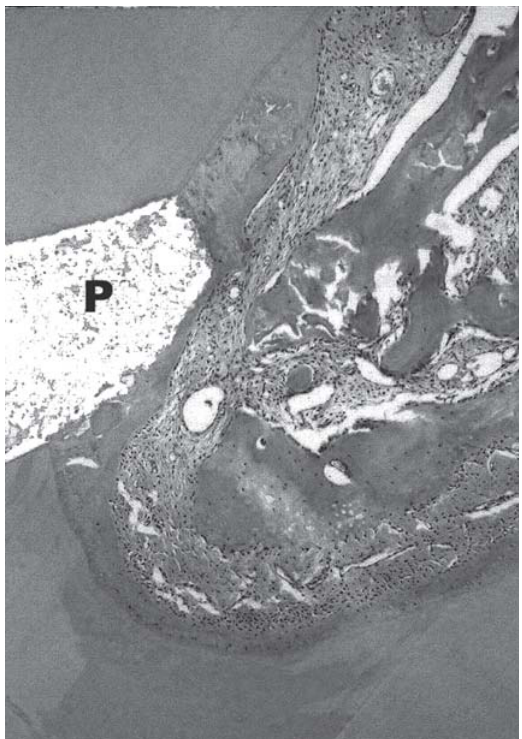
FIGURE1- ProRoot MTA, revealing the mineralized sealing at the perforation (P), with no inflammation and with organization of the periodontal ligament. Hematoxylin and eosin – Olympus 10X